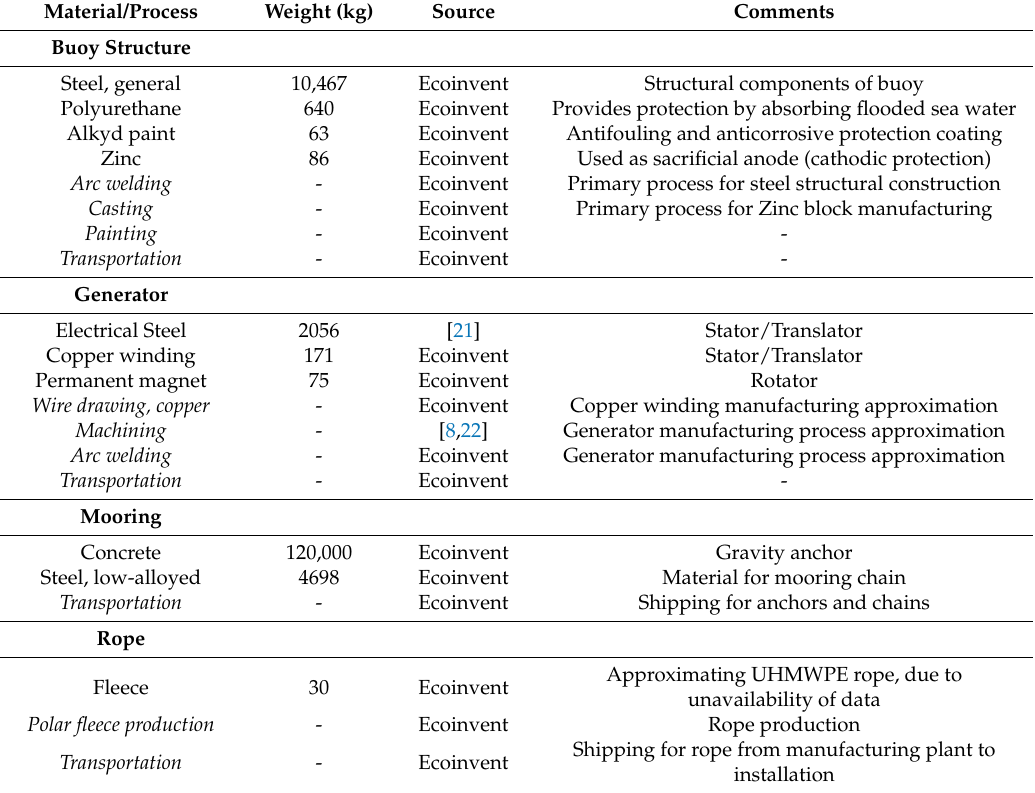
Table 1. Primary materials and processes for BRD WEC manufacturing, assembly and